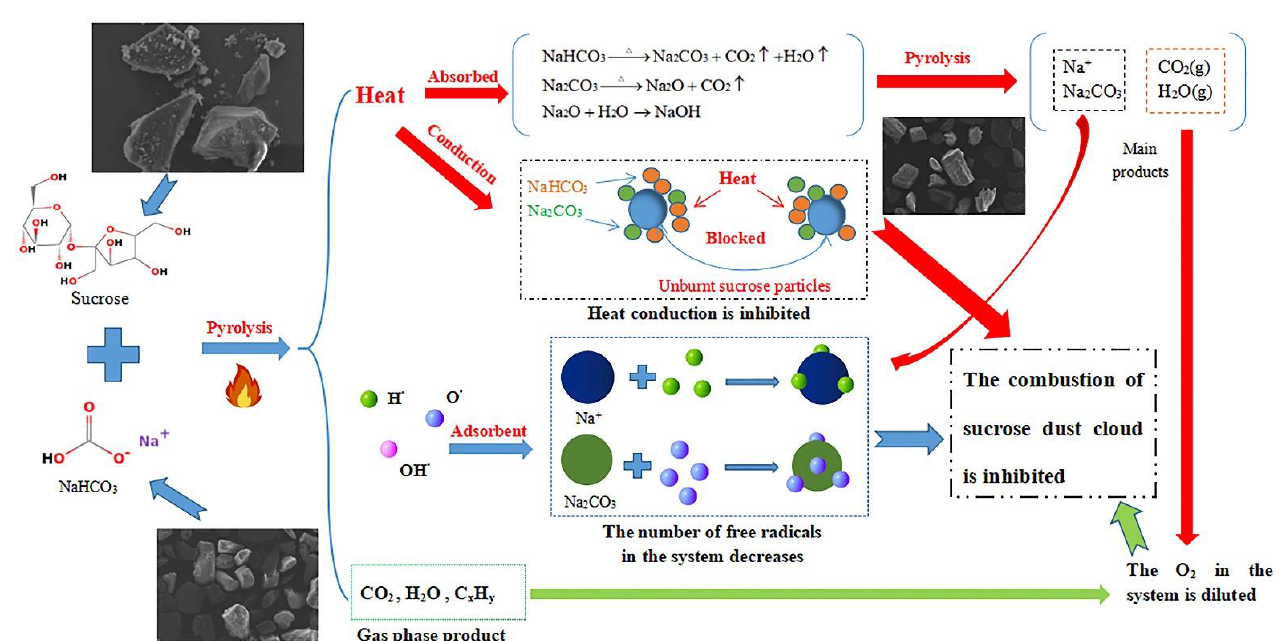
Figure 5. Inhibition mechanism of NaHCO 3 on sucrose dust combustion.